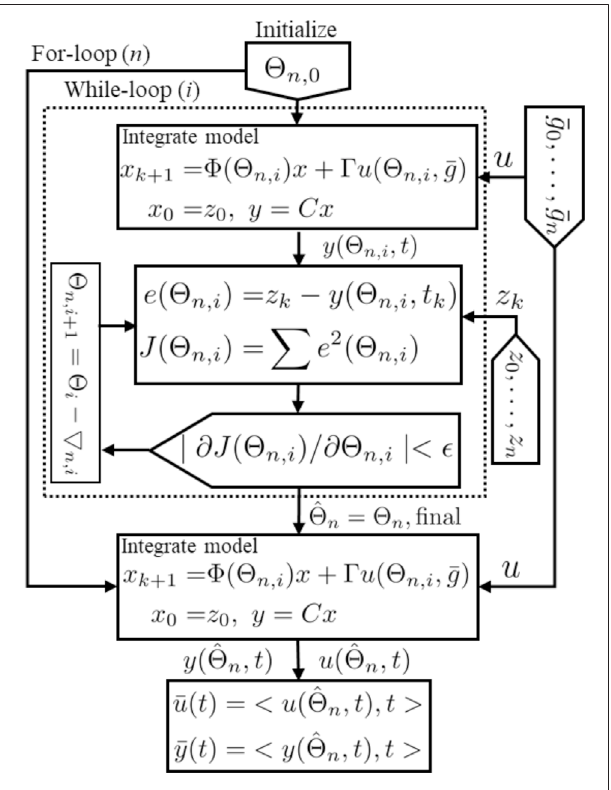
FIGURE 3 | Schematic representation for the estimation